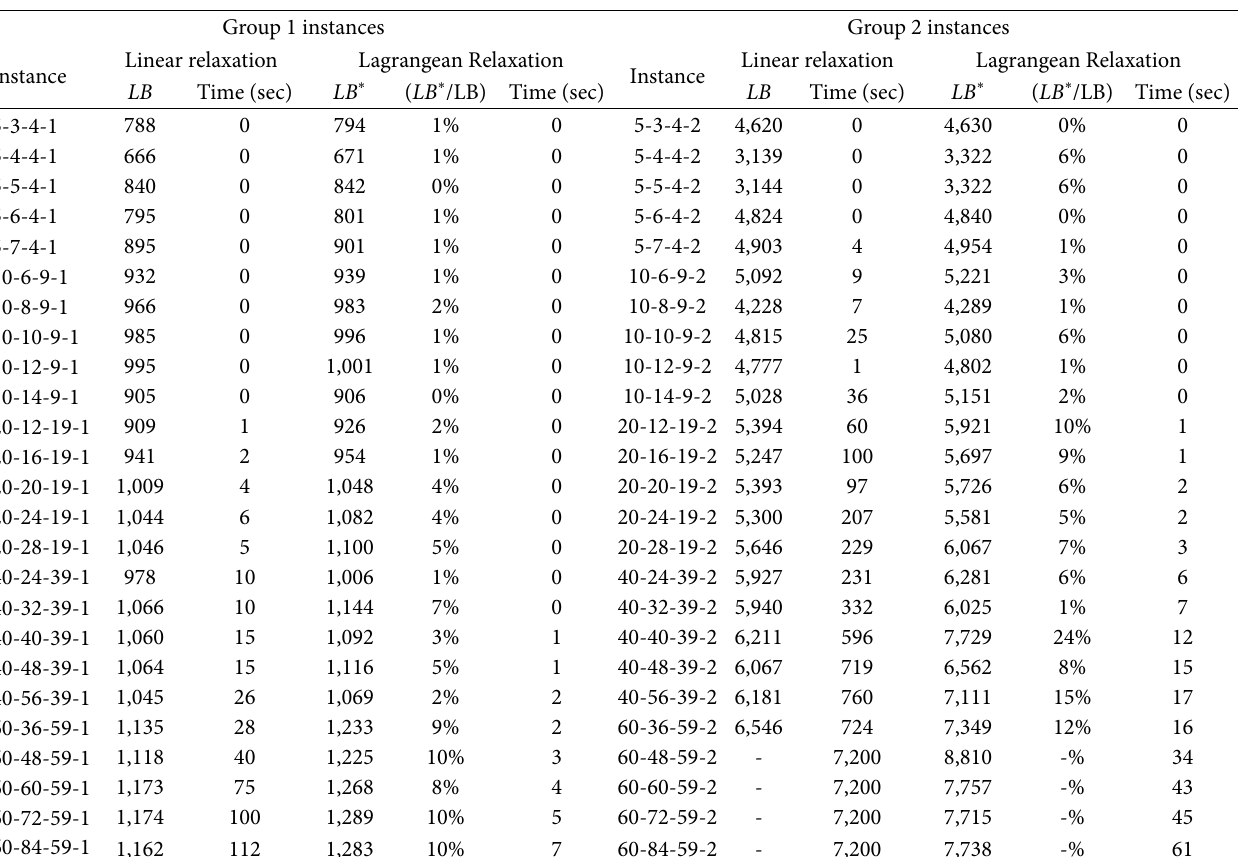
Table 3: Results obtained with the linear relaxation and the LR on instances of groups 1 and 2. The LB vided by the Lagrangean Relaxation. Likewise, LB values refer to the lower bounds computed by the linear